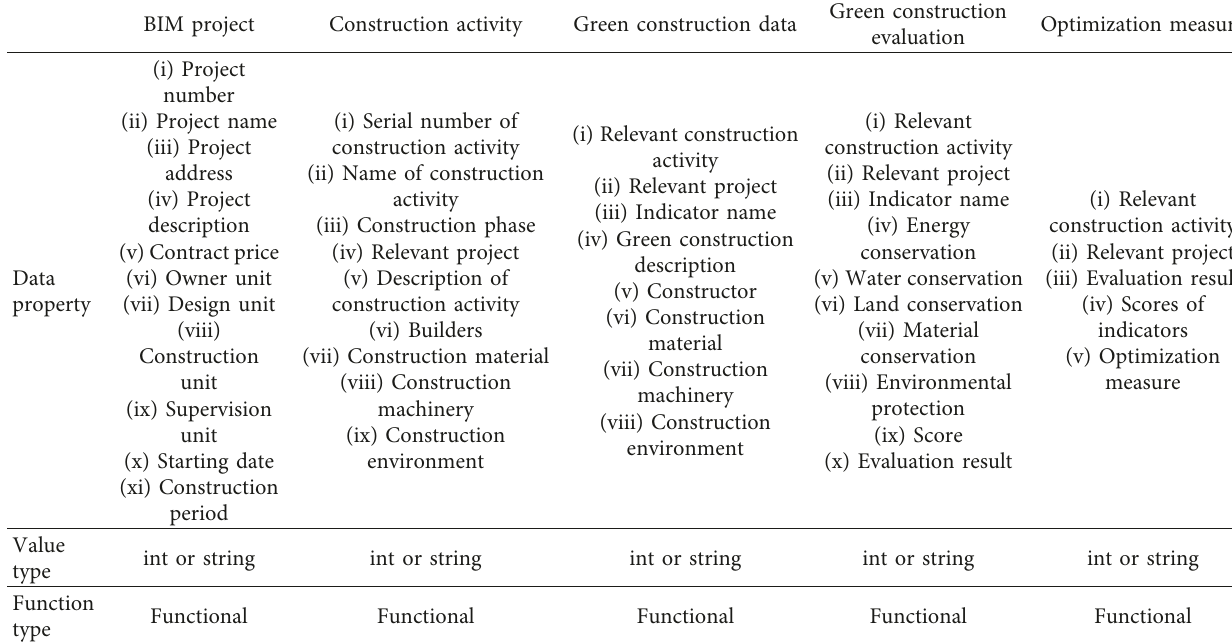
Table 7: The definition of data